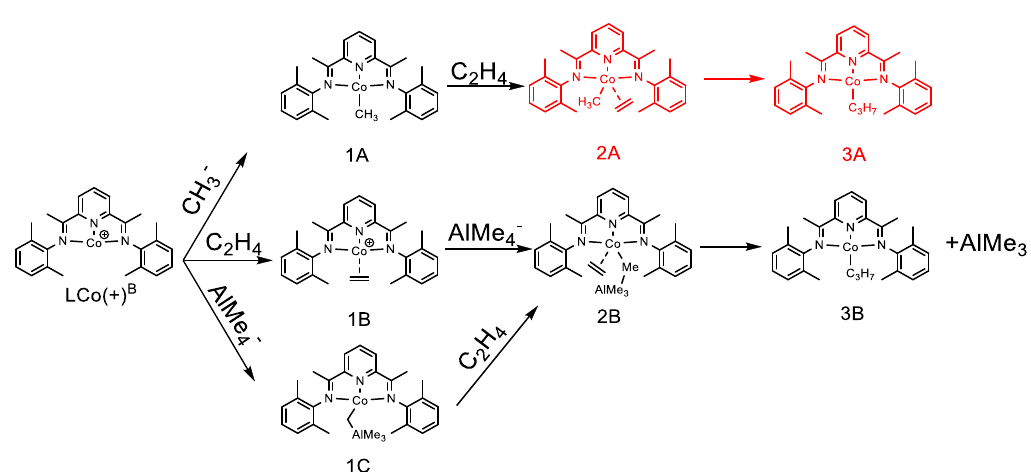
Scheme 5. The reaction pathway of ethylene polymerization catalyzed by L s Co(+) B on addition of [CH 3 ] − or [AlMe 4 ] − or C 2 H 4 .